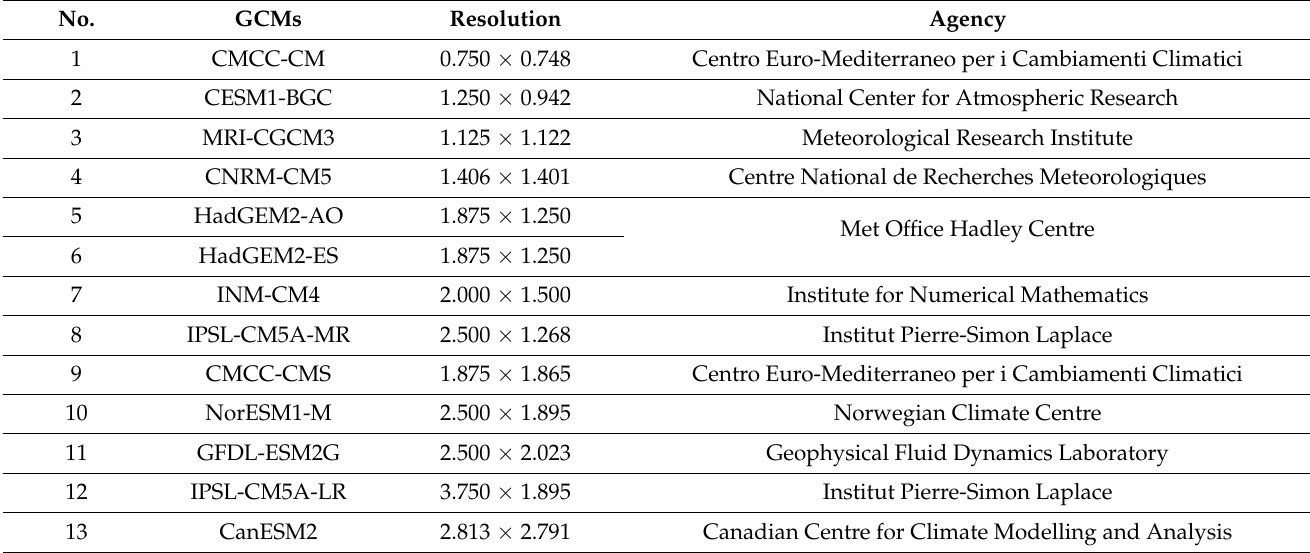
Table 1. GCM models used for APCC’s climate scenarios.